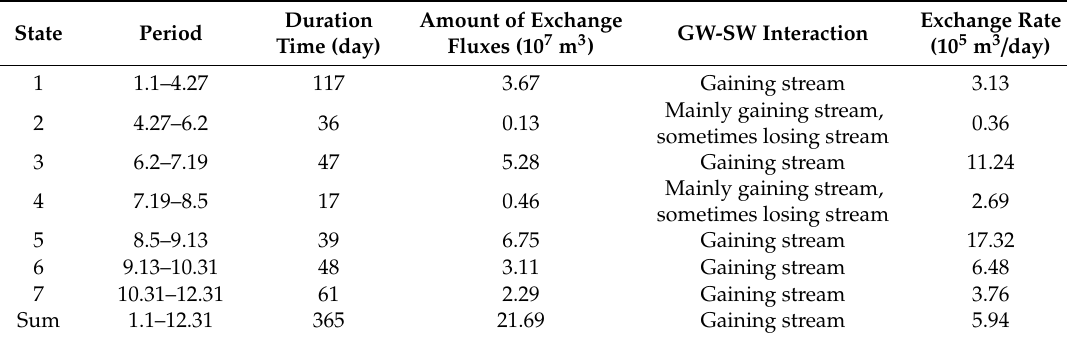
Table 4. Results of the volume and rate of exchange fluxes.